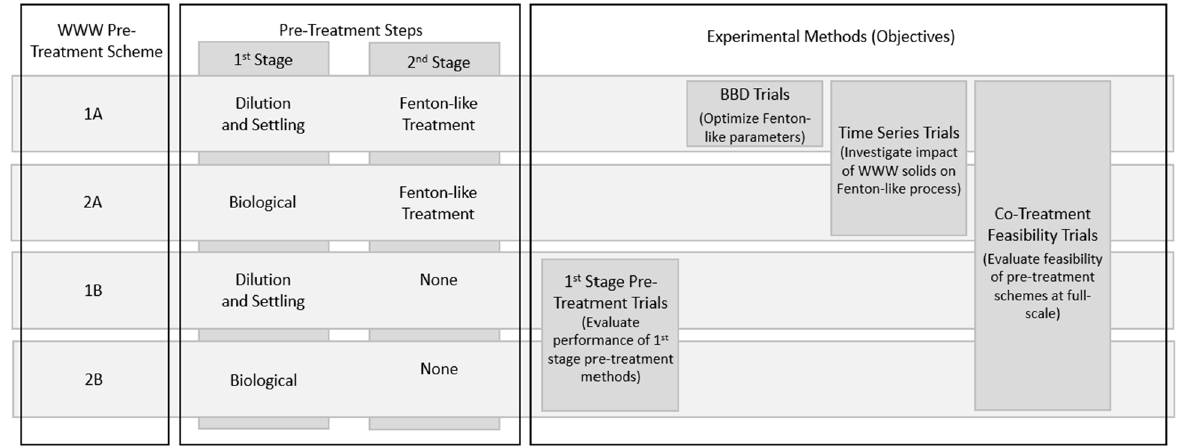
Figure 2. Alternative WWW pre-treatment schemes evaluated as part of this study.